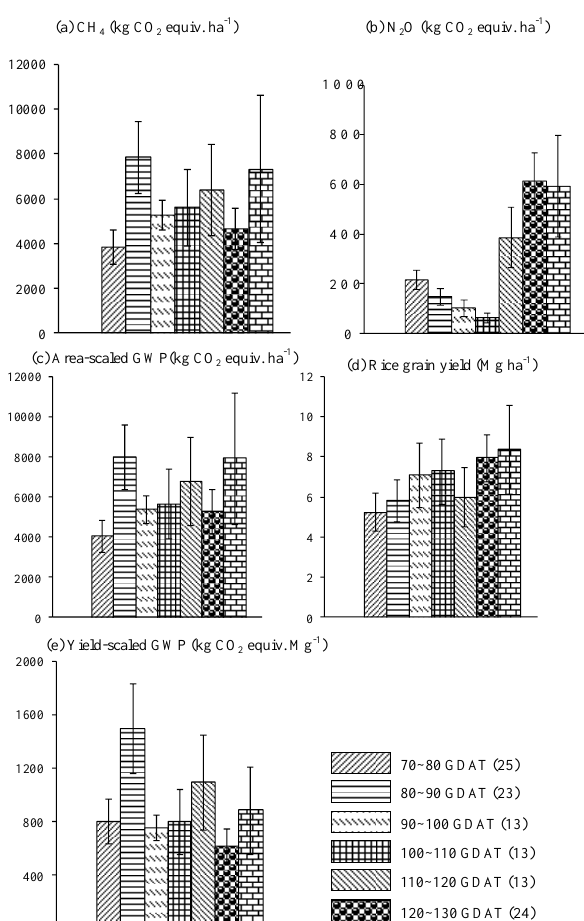
4 and N 2 O emissions, area-scaled GWP, rice grain yield, and yield-scaled GWP during different growth duration after transplanting (GDAT). The data in the bracket were the numbers of observation. All error bars repre- sented 95% confidence